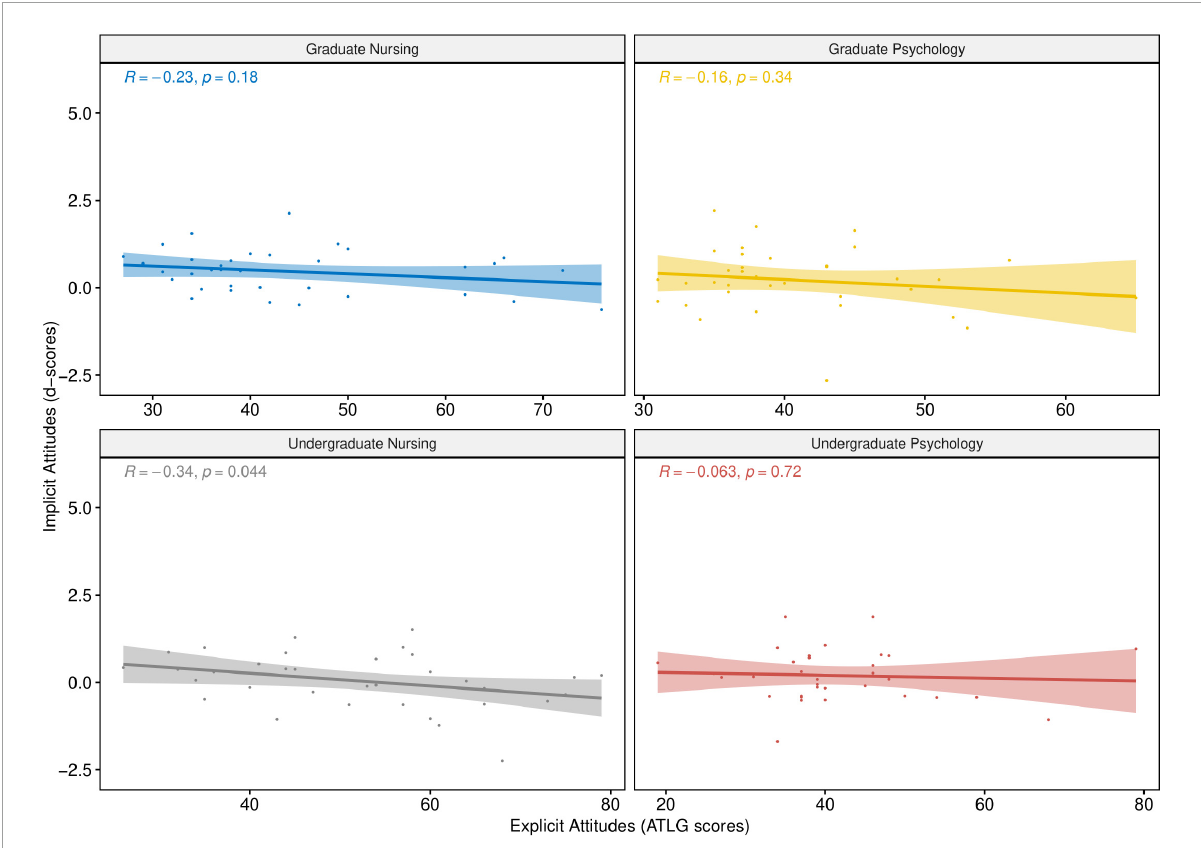
FIGURE1 Pearson correlation (with a 95% confidence intervals ) between implicit and explicit attitudes among each of the four study groups.